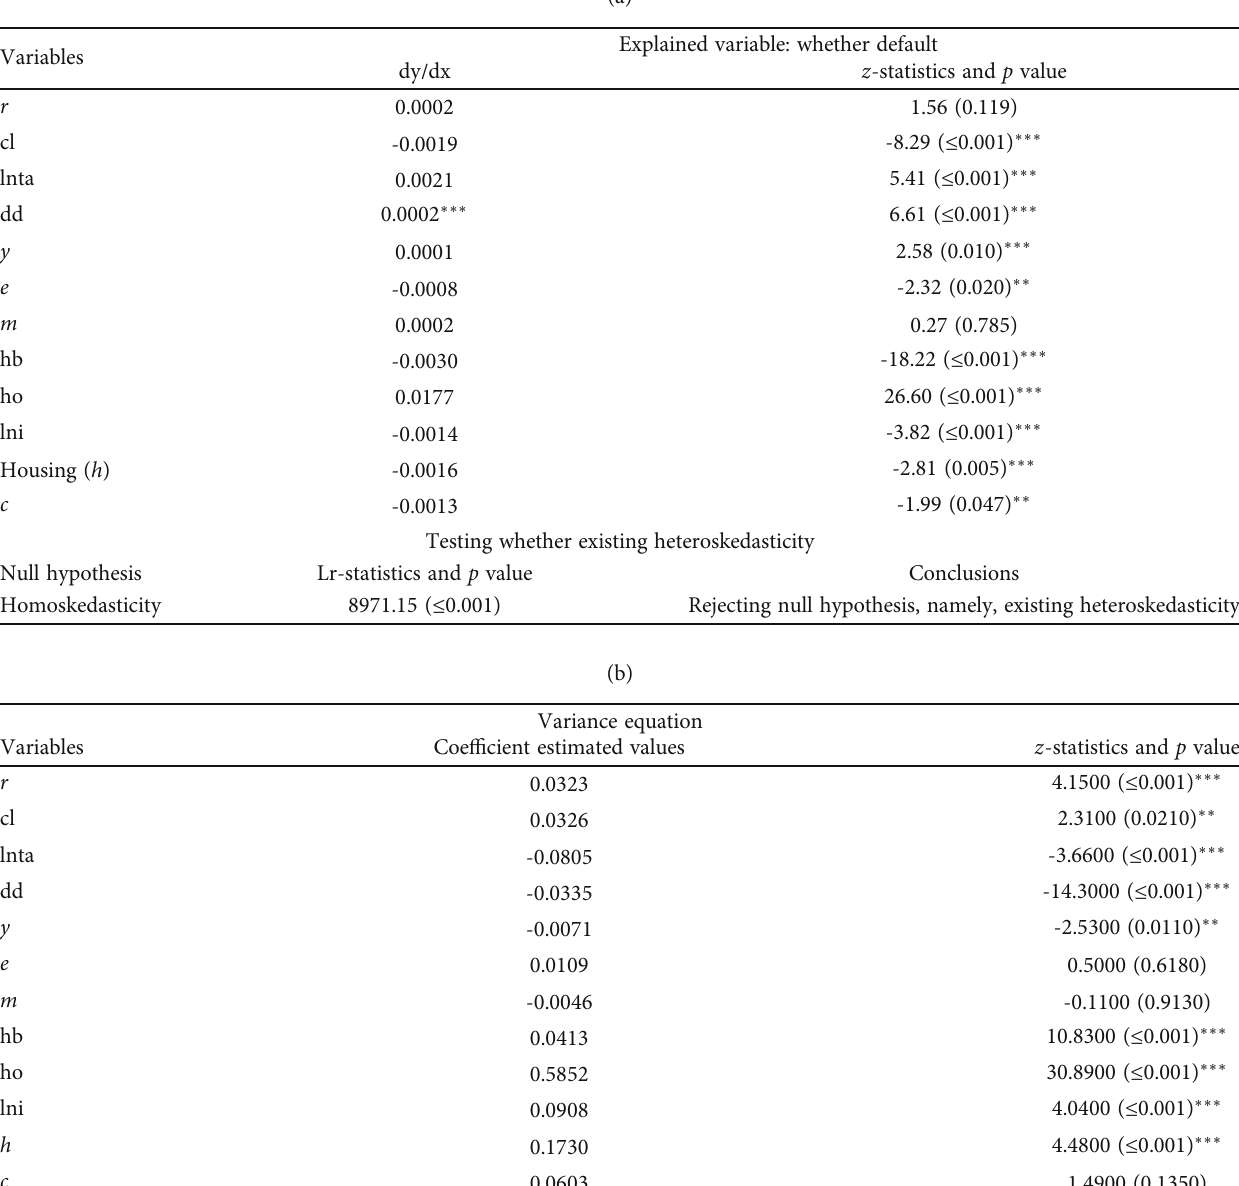
Table 3: Multifactor estimated results of heteroskedasticity Probit model of